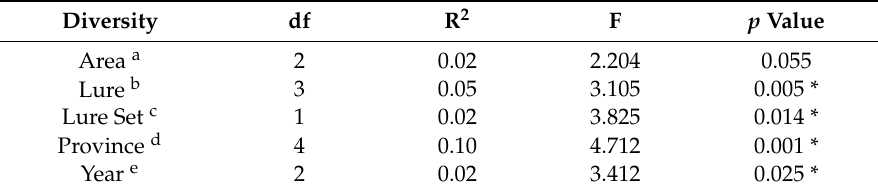
Table 2. Permutational multivariate analysis of variance (PERMANOVA) of fungal diversity in relation to area of collection, or lure, or lure set, or province or year of collection, using distance matrices (999 permutations) and calculated according to the Jaccard similarity method. R 2 = R-square statistic, F = F-statistic, df = degrees of freedom; p value calculated at a confidence interval of 95%. Diversity df R 2